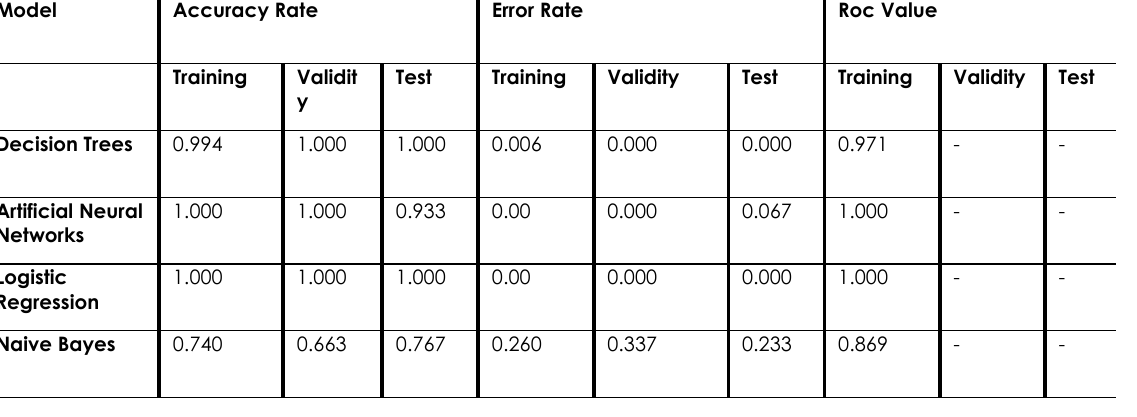
Table 10. Model comparison fit statistics. Model